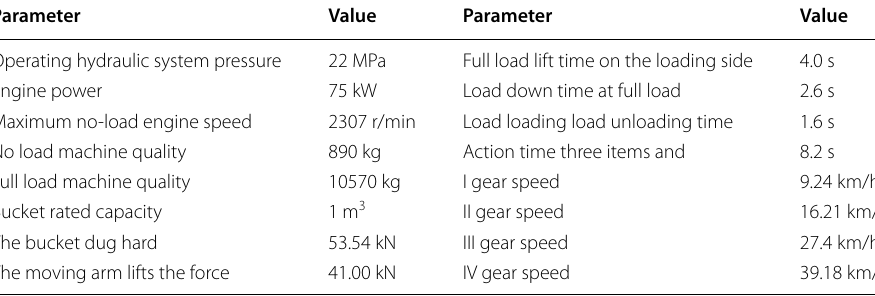
Table 2 Loader-digger